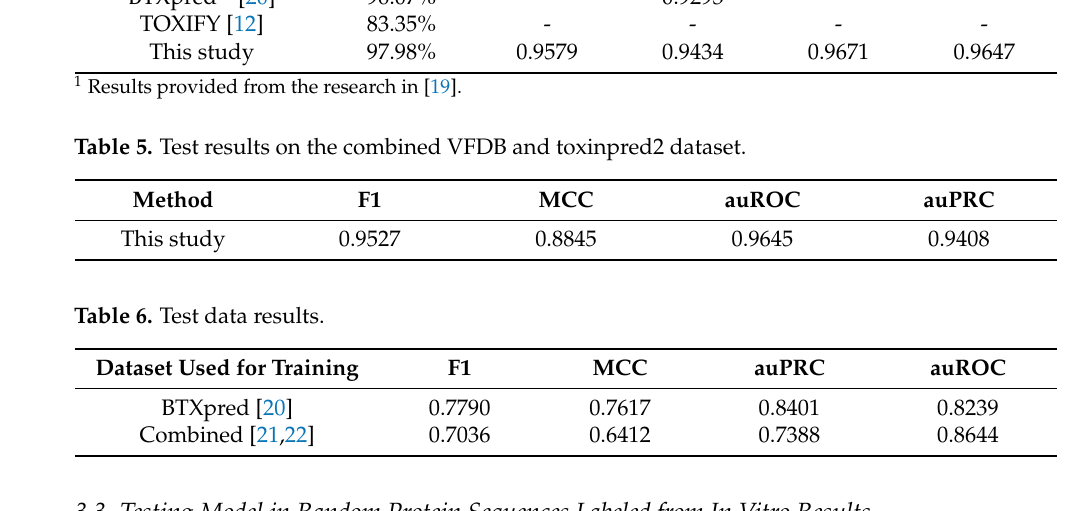
Table 5. Test results on the combined VFDB and toxinpred2 dataset.